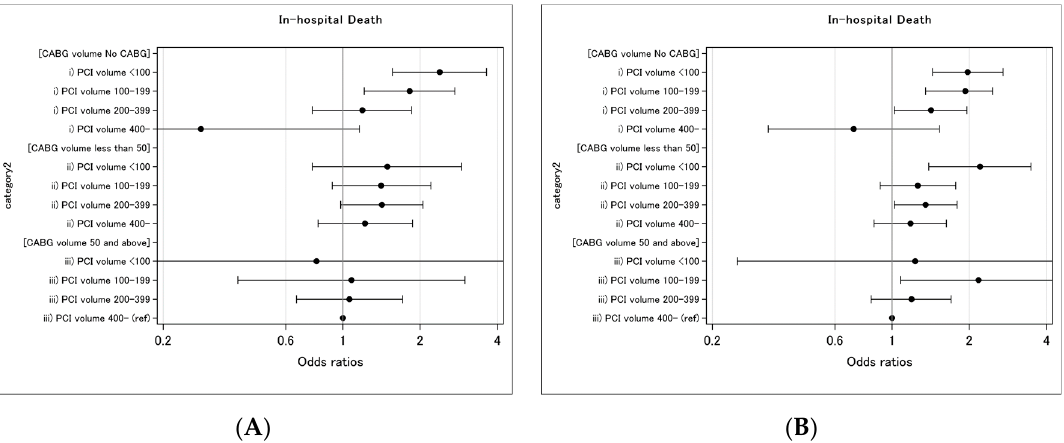
Figure 2. Hazard for in-hospital death ( A ) and composite outcome ( B ) in PCI patients by the volume of CABG. Odds ratios are reported on a log scale.